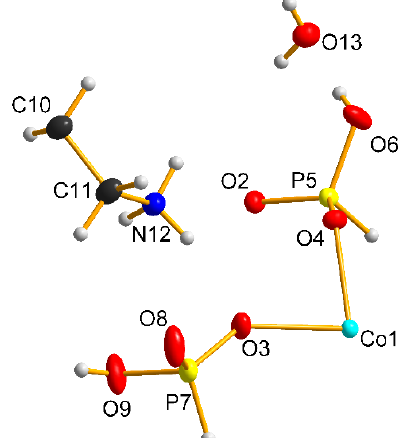
Figure 1. Asymmetric unit of (H 2 DAB)[Co(H 2 PO 3 ) 4 ]·2H 2 O. Thermal ellipsoids are shown at 60% probability.